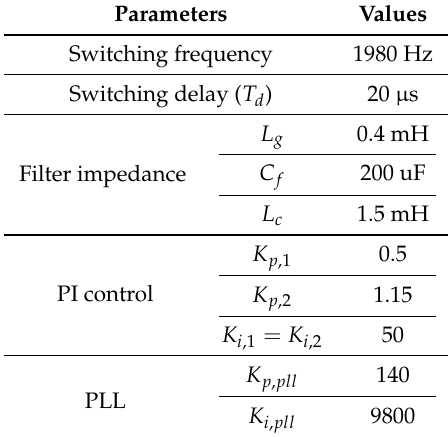
Table A2. Converter